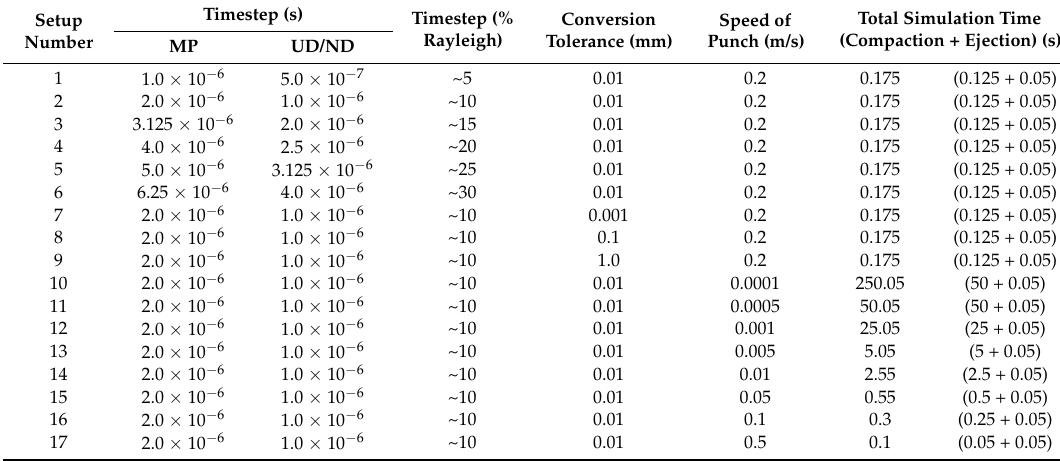
Table 2. Setup of DEM